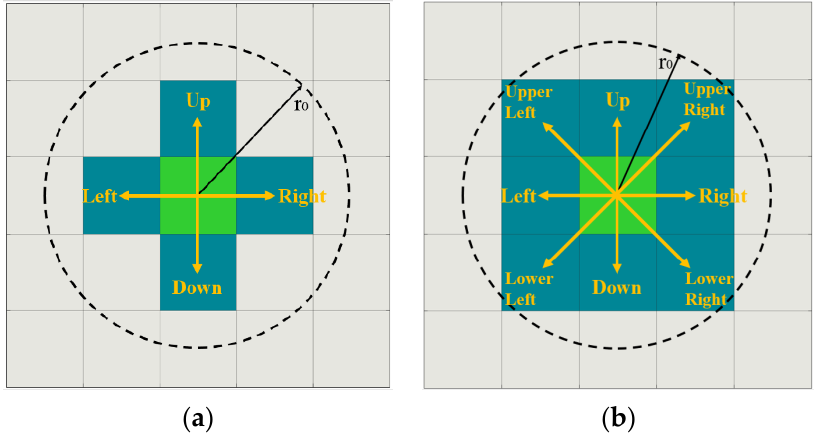
Figure 7. Direction of motion of different algorithm: ( a ) BINN algorithm. ( b ) CCNN algorithm.